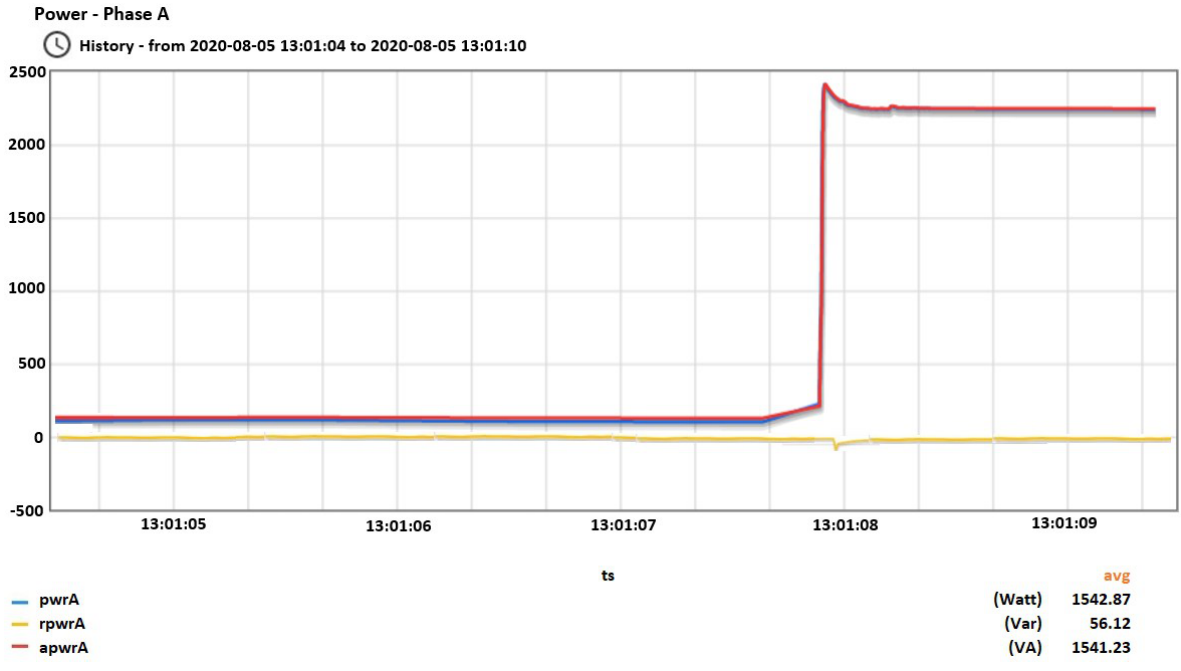
Figure 15. Stove’s